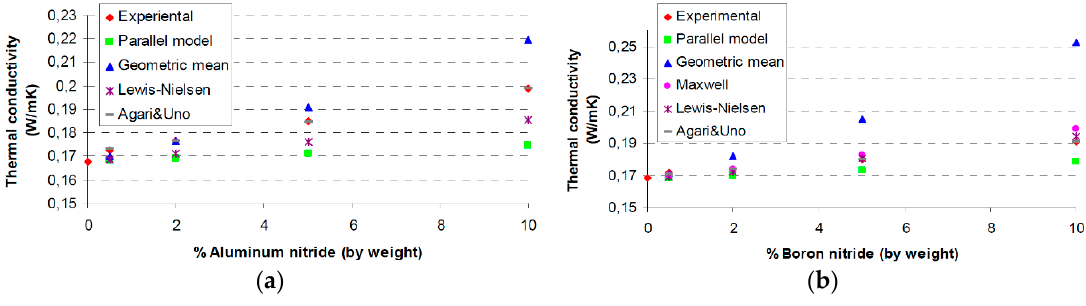
Figure 38. Experimental and predicted thermal conductivity data for ( a ) epoxy resin/AlN and ( b ) epoxy resin/BN composites at 18 °C (© 2016 IEEE. Reprinted, with permission, from [172]).